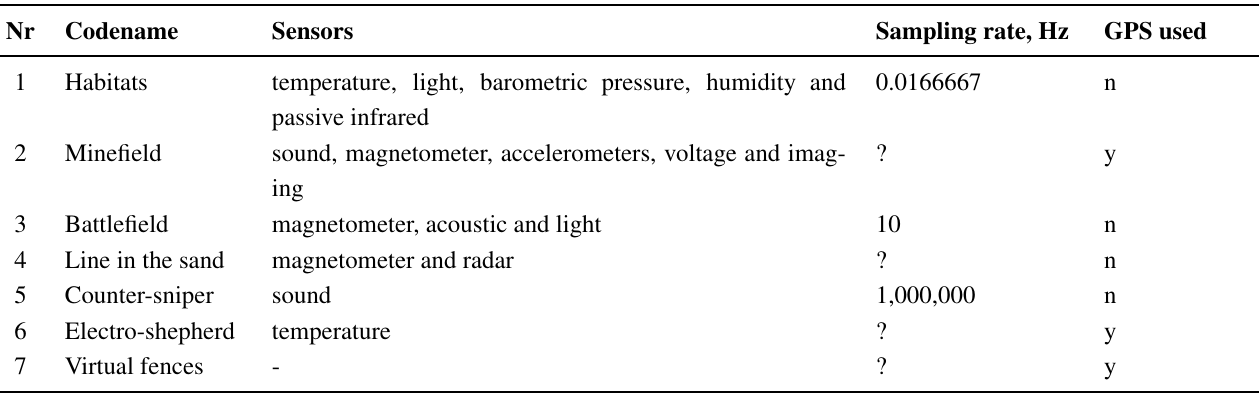
Table 3. Deployments: